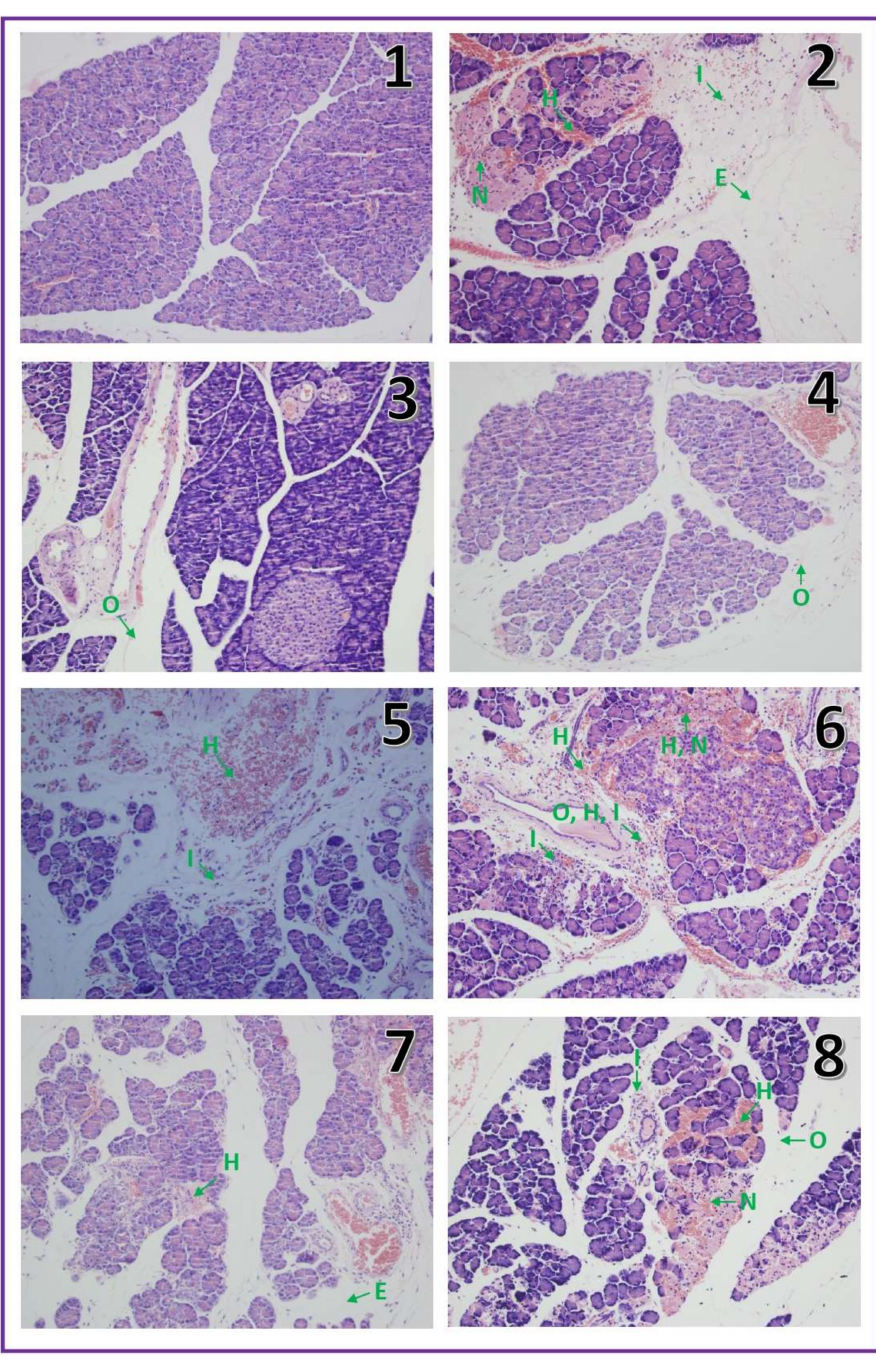
Figure 2. Representative morphological features of the pancreas observed in sham-operated saline-treated control rats ( 1 ), rats with ischemia / reperfusion-induced acute pancreatitis ( 2 ), rats treated with warfarin at a dose of 90 µ g / kg / dose without induction of acute pancreatitis ( 3 ), rats treated with warfarin at a dose of 180 µ g / kg / dose without induction of acute pancreatitis ( 4 ), rats treated with warfarin at a dose of 270 µ g / kg / dose without induction of acute pancreatitis ( 5 ), rats pretreated with warfarin at a dose of 90 µ g / kg / dose before induction of acute pancreatitis ( 6 ), rats pretreated with warfarin at a dose of 180 µ g / kg / dose before induction of acute pancreatitis ( 7 ), rats pretreated with warfarin at a dose of 270 µ g / kg / dose before induction of acute pancreatitis ( 8 ); The arrow with E means edema, with I: inflammatory infiltration, with V: vacuolization, with N: necrosis with H: hemorrhages. Hematoxylin-eosin stain, original magnification 200 ×